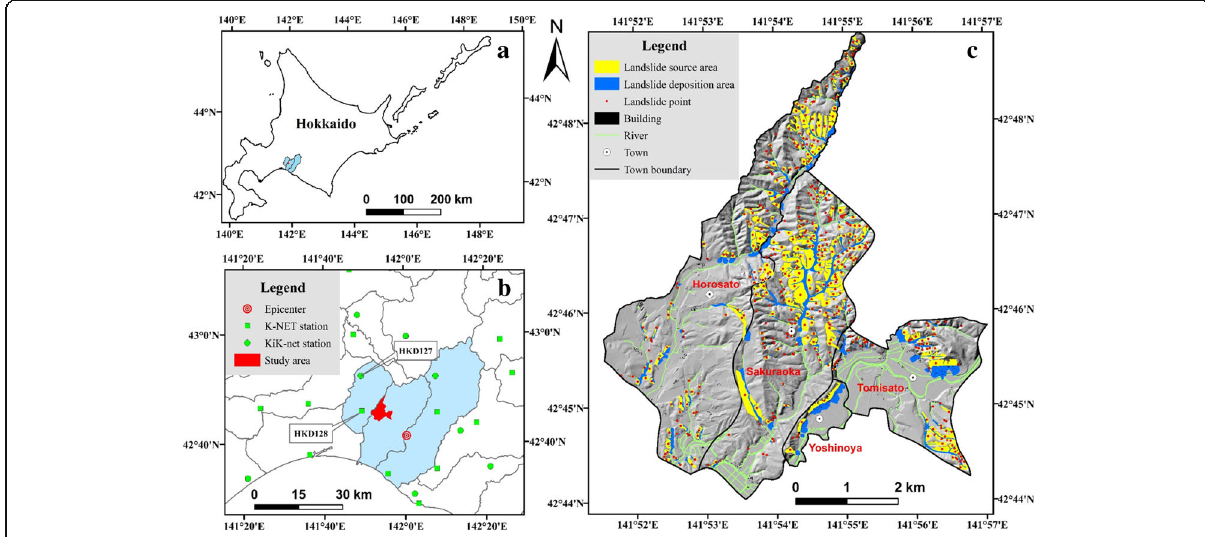
Fig. 1 Location maps and coseismic landslides in the study area ( a ) General view of the study area. b Realtime ground-motion monitoring stations (K-NET station and KiK-net station) distributed around the study area. c Coseismic landslides triggered by the Iburi earthquake in the study area. The shaded relief map was generated from a 5 × 5 m